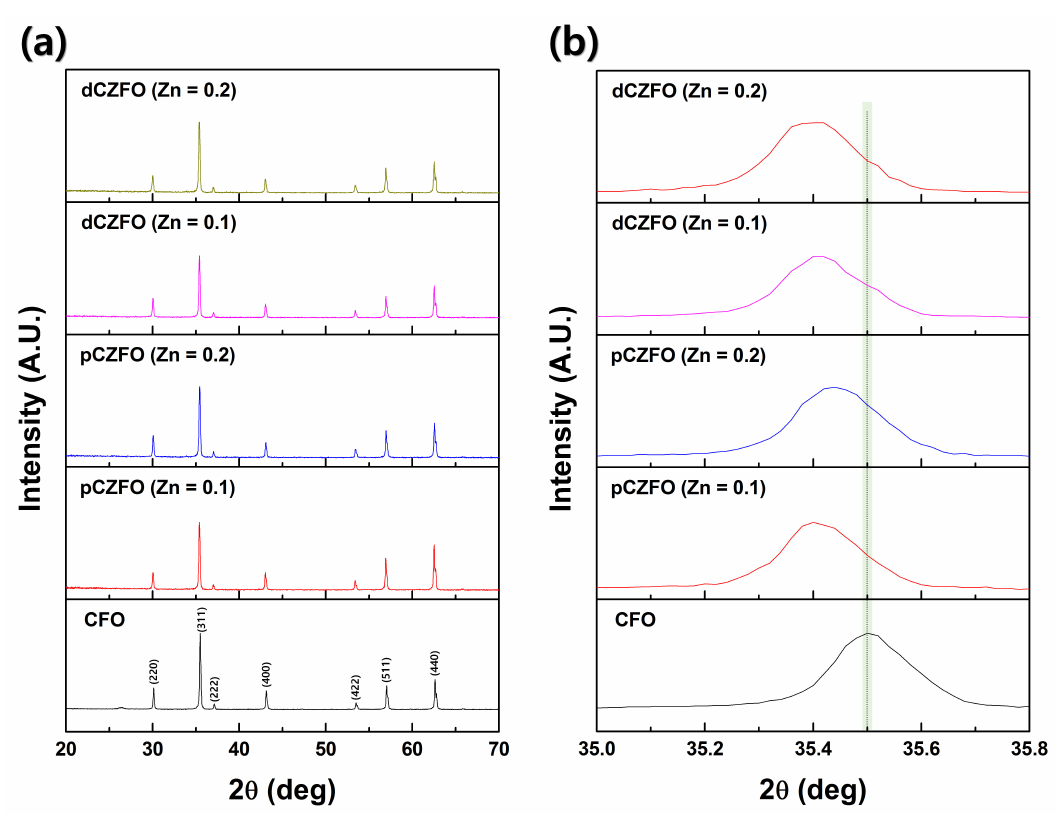
Figure 2. XRD patterns of CFO, pCZFO (Zn = 0.1, 0.2) and dCZFO (Zn = 0.1, 0.2) powders; ( a ) wide range 2 θ of 20–70 ◦ and ( b ) narrow range 2 θ of 35.0–35.8 ◦